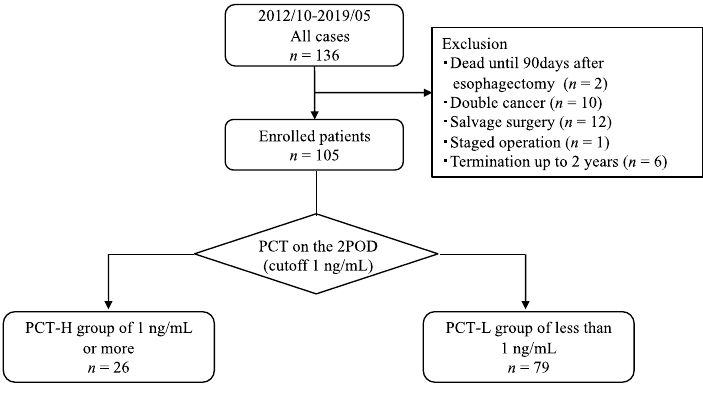
Figure 1. Study design diagram.